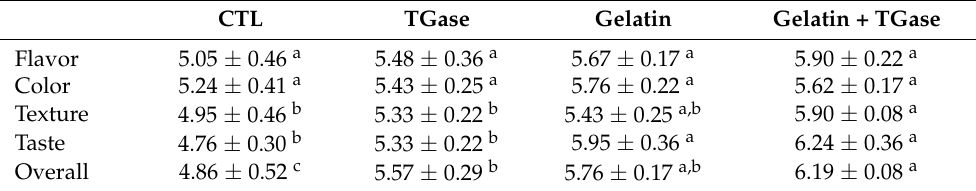
Table 3. Sensory attributes of restructured ham with gelatin and